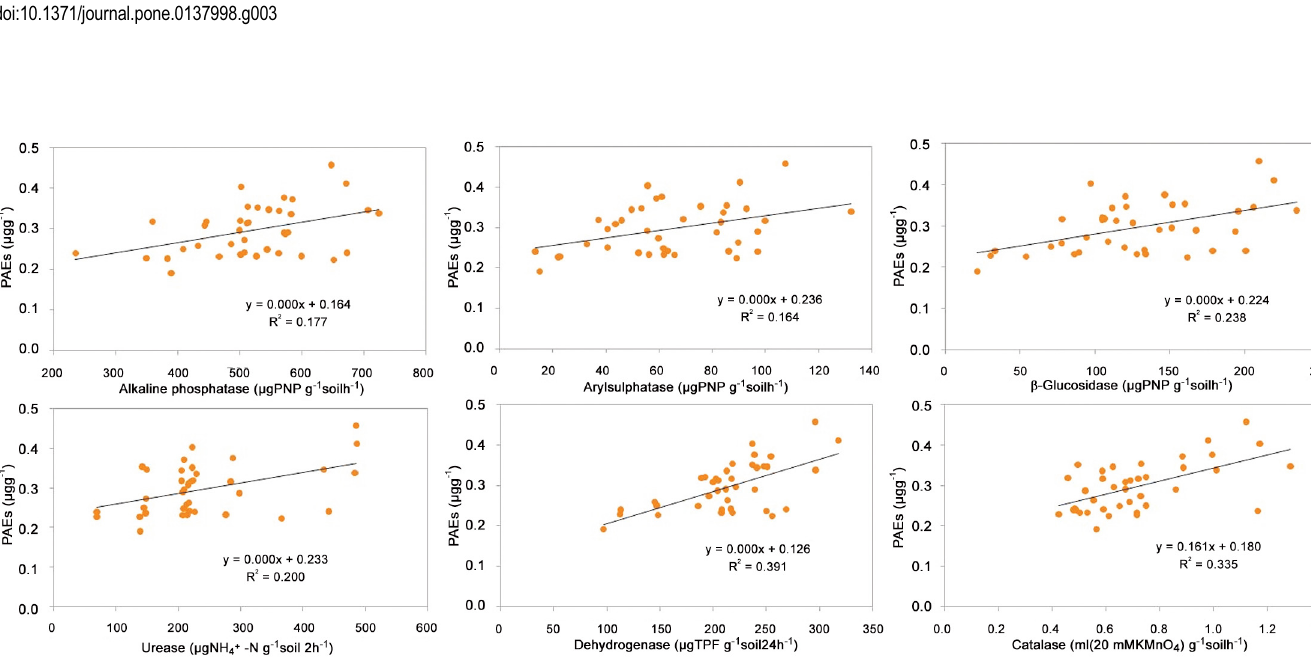
PLOS ONE | DOI:10.1371/journal.pone.0137998 September 11,